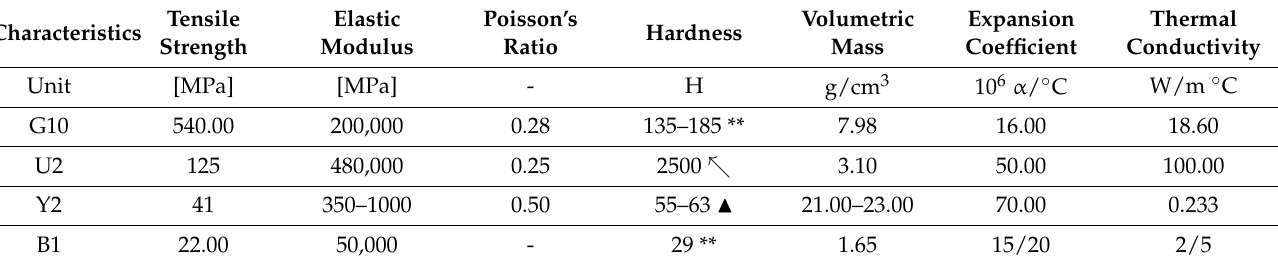
Table 4. Physical-mechanical and thermal characteristics of the materials